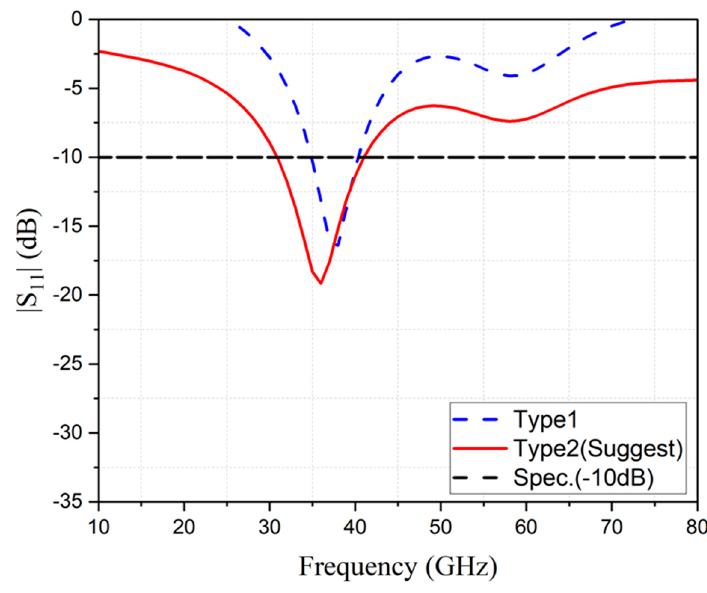
Figure 10. Reflection coefficients (S11) of different types of AMC.